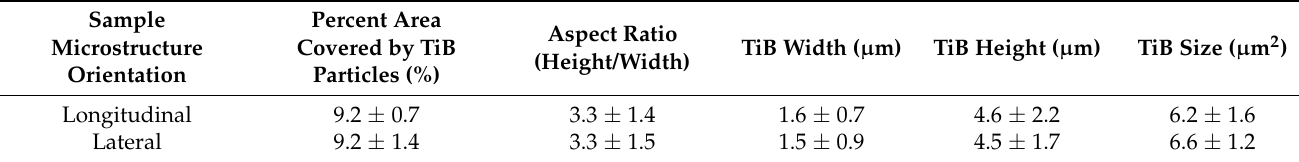
Table 1. Average TiB analysis distribution summary obtained from three SEM micrographs at 200 × magnification (regions approximately 685 µ m by 590 µ m in size).